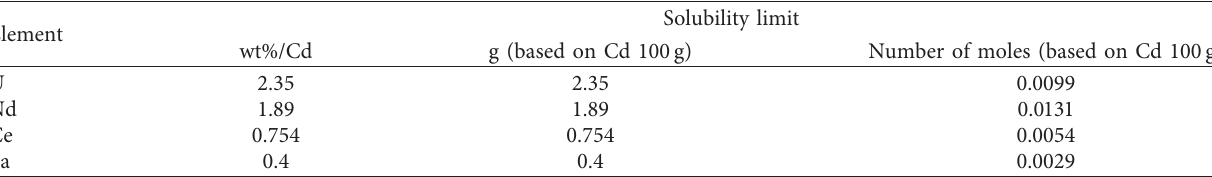
Figure 7: Potential profiles gathered during run 6 using the stirred LCC immersed in LiCl-KCl-UCl Table 3: Solubility limit of metal elements in Cd at 500 ° C